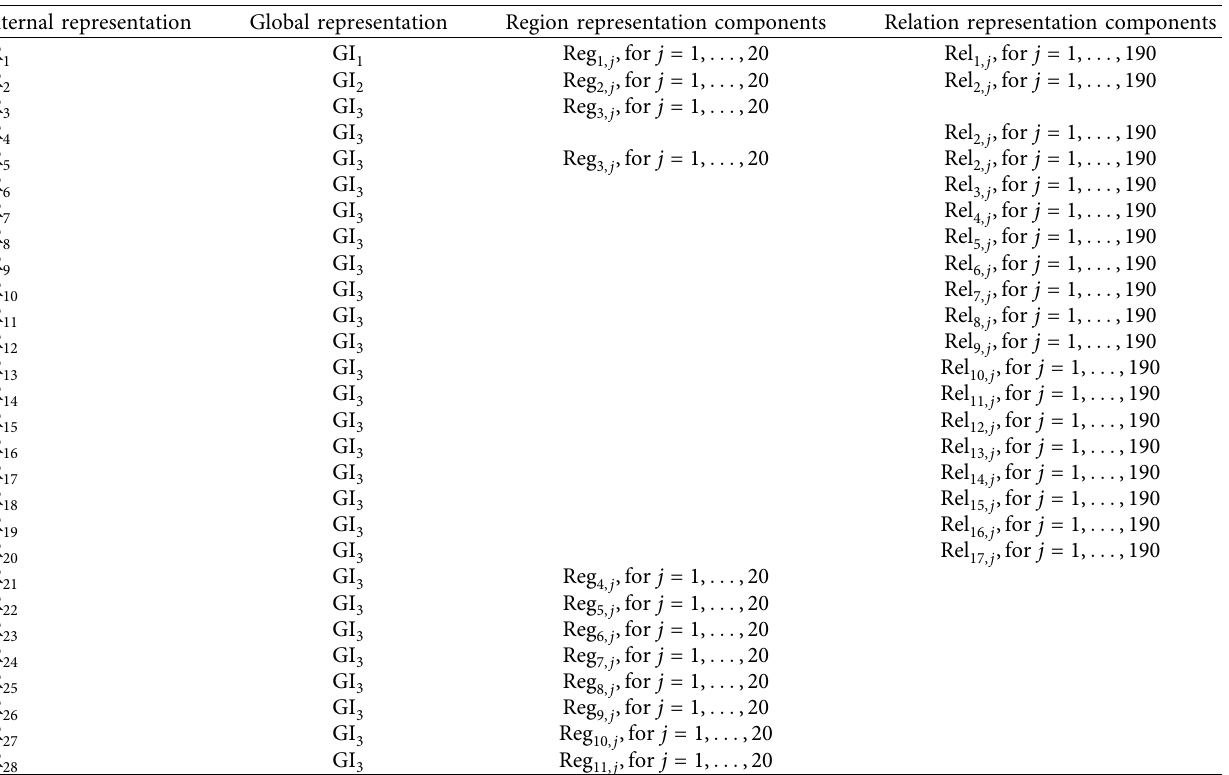
Table 1: Internal